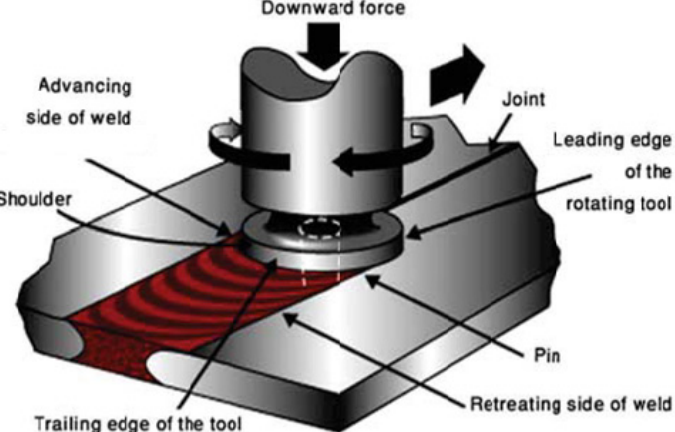
Figure 1: Schematic diagram of the FSW